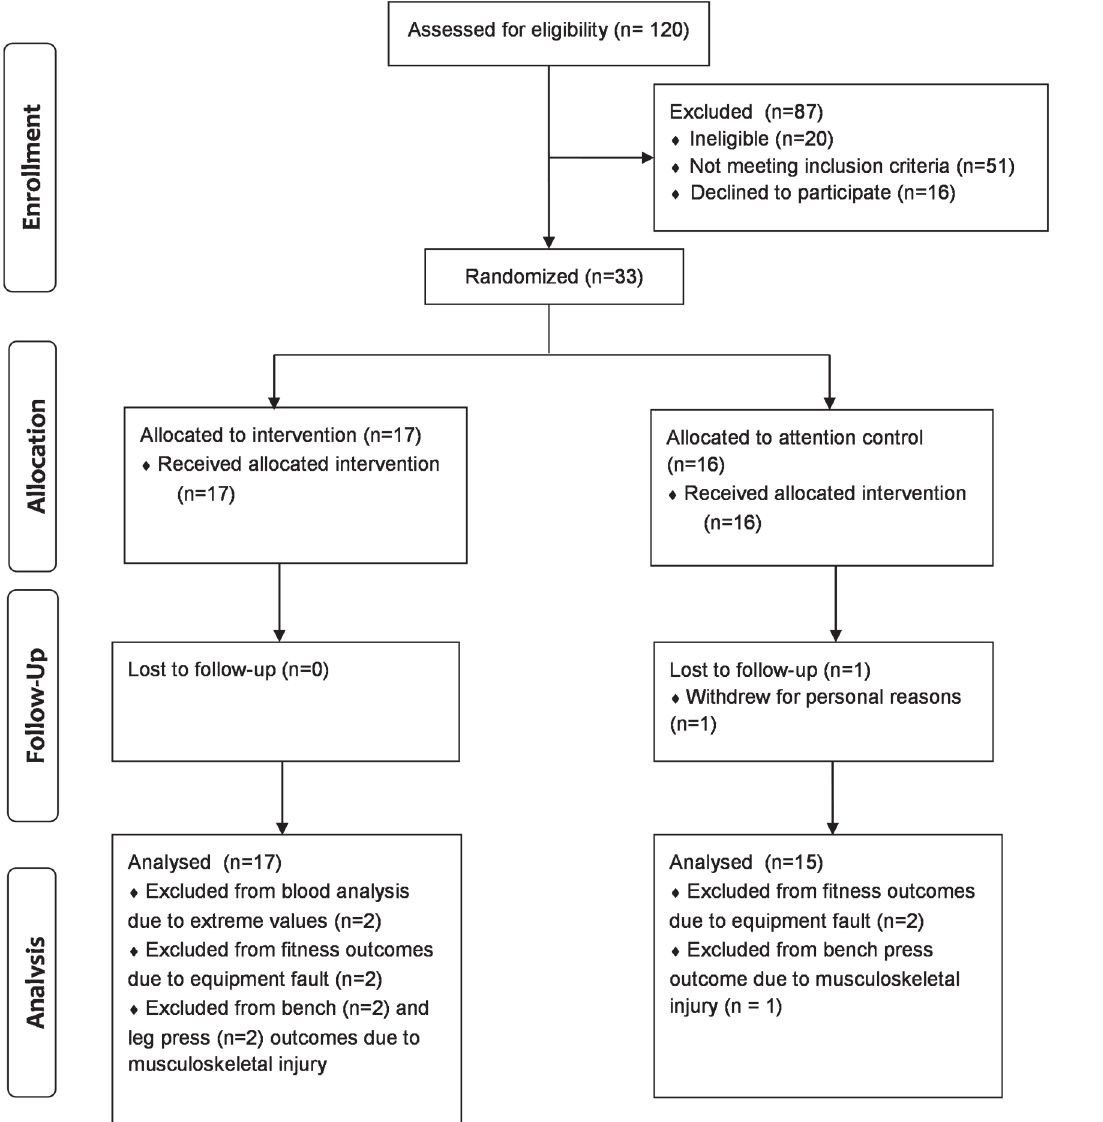
Fig 1. Participant flow